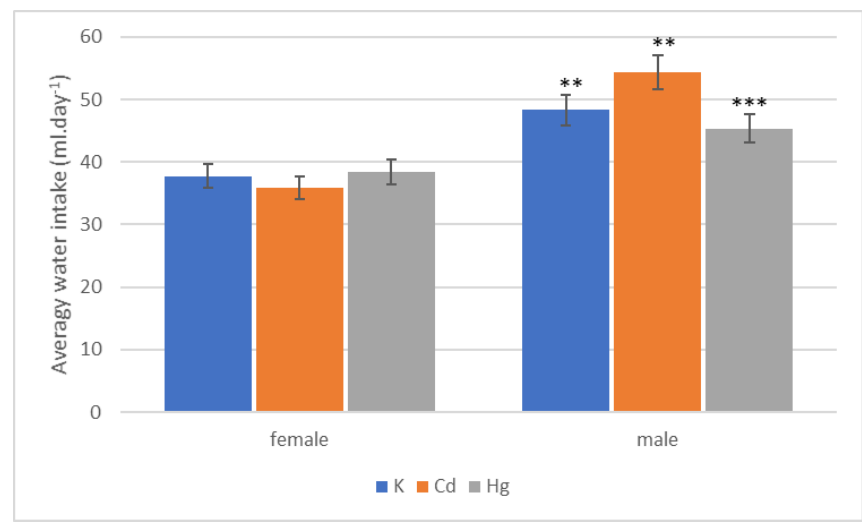
Figure 2. A comparison of water intake after 52 weeks of the experiment. ** p < 0.001, for K/Cd groups compared to corresponding female groups; *** p < 0.05, for Cd male group compared to Hg male group; n = 8 per group. Table 5. Average food intake of female rats ± SD.